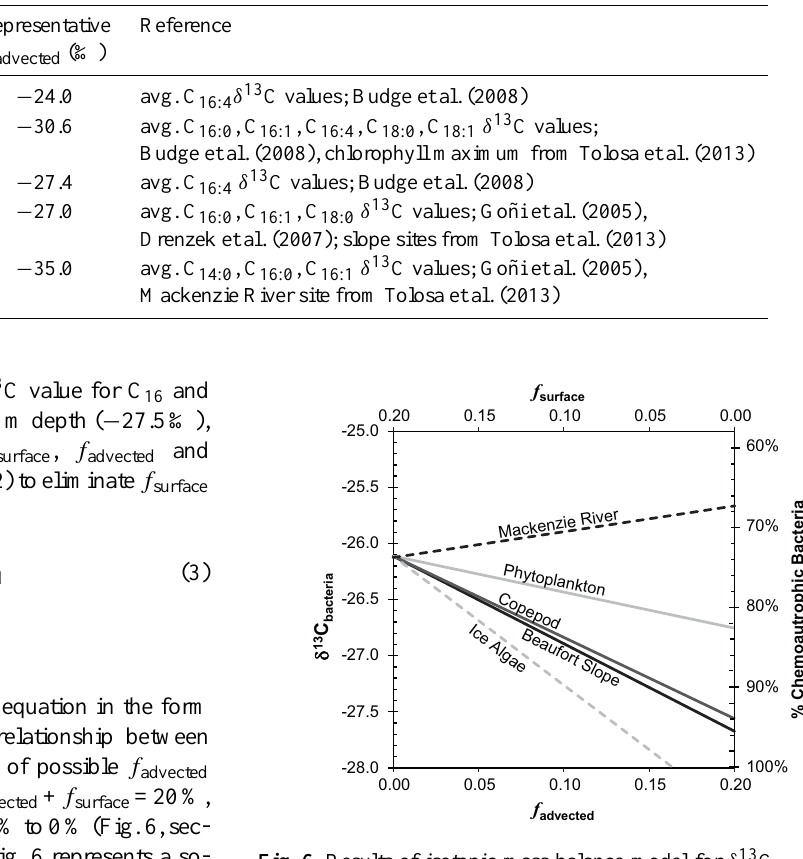
Table 3. δ 13 C values of organic matter sources that could be laterally supplied to Canada Basin.